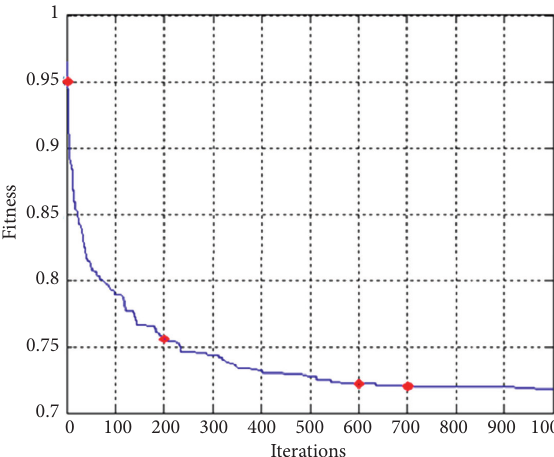
Figure 12: Distribution of aircraft types.